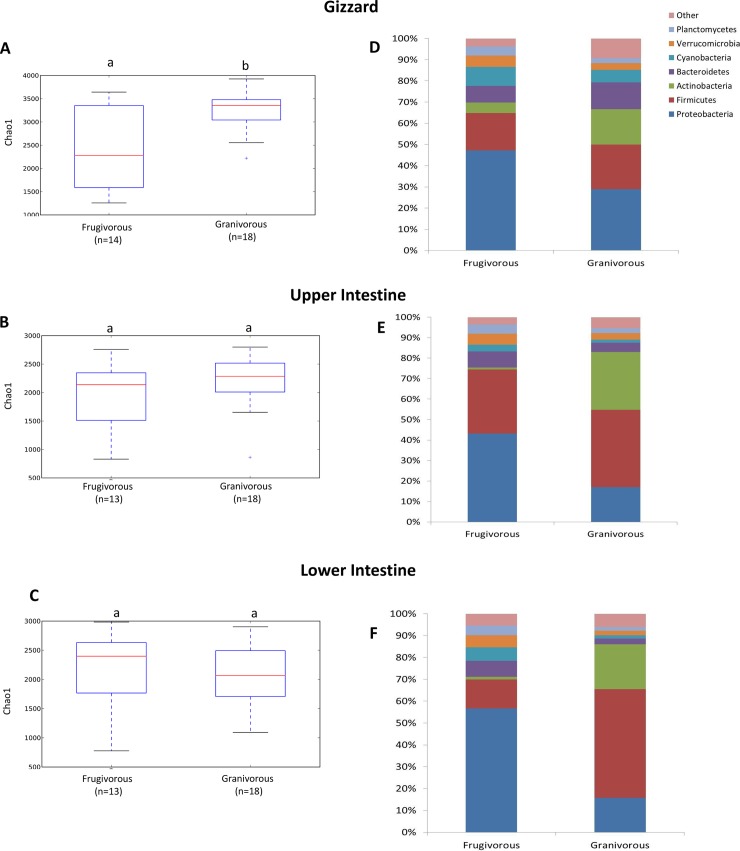
Alpha diversity of gut bacterial communities by frugivorous and granivorous birds in different organs.A, B and C) Bacterial community richness (Chao1 index) for the gizzard, upper and lower intestine. D, E and F) Relative abundances of phyla (%) present in the gizzard, upper and lower intestine. Different letters above boxplots indicate significant differences (non-parametric t-test ≤0.05).